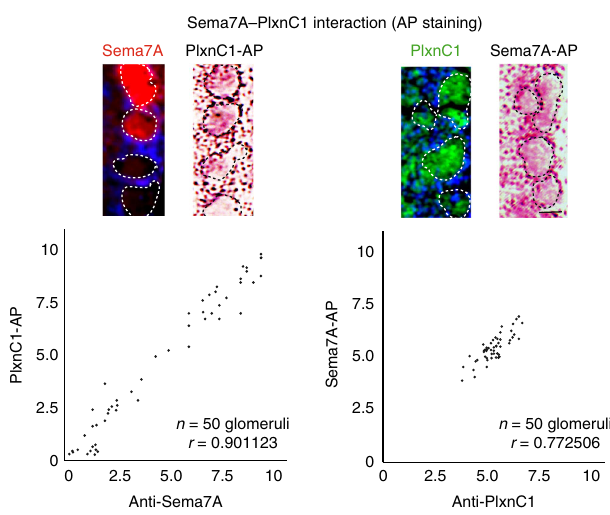
Fig. 3 Physical interaction of Sema7A and PlxnC1 in the OB. Sema7A – PlxnC1 interaction was detected by the binding assay with AP- fusion proteins. Two consecutive OB sections at P4 were stained with PlxnC1-AP and immunostained with antibodies against Sema7A (left). OB sections were also stained with Sema7A-AP and immunostained with antibodies against PlxnC1 (right). Positive correlations are found between the AP-staining and immunostaining signals. The Pearson ’ s correlation coef fi cient was calculated ( r ). n = 50 glomeruli. Scale bar = 25 μ